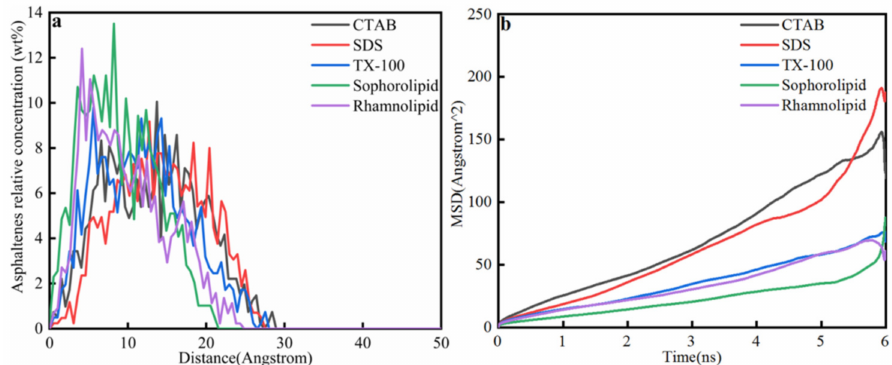
Figure 15. ( a ) Asphaltenes relative concentration; ( b ) Mean square